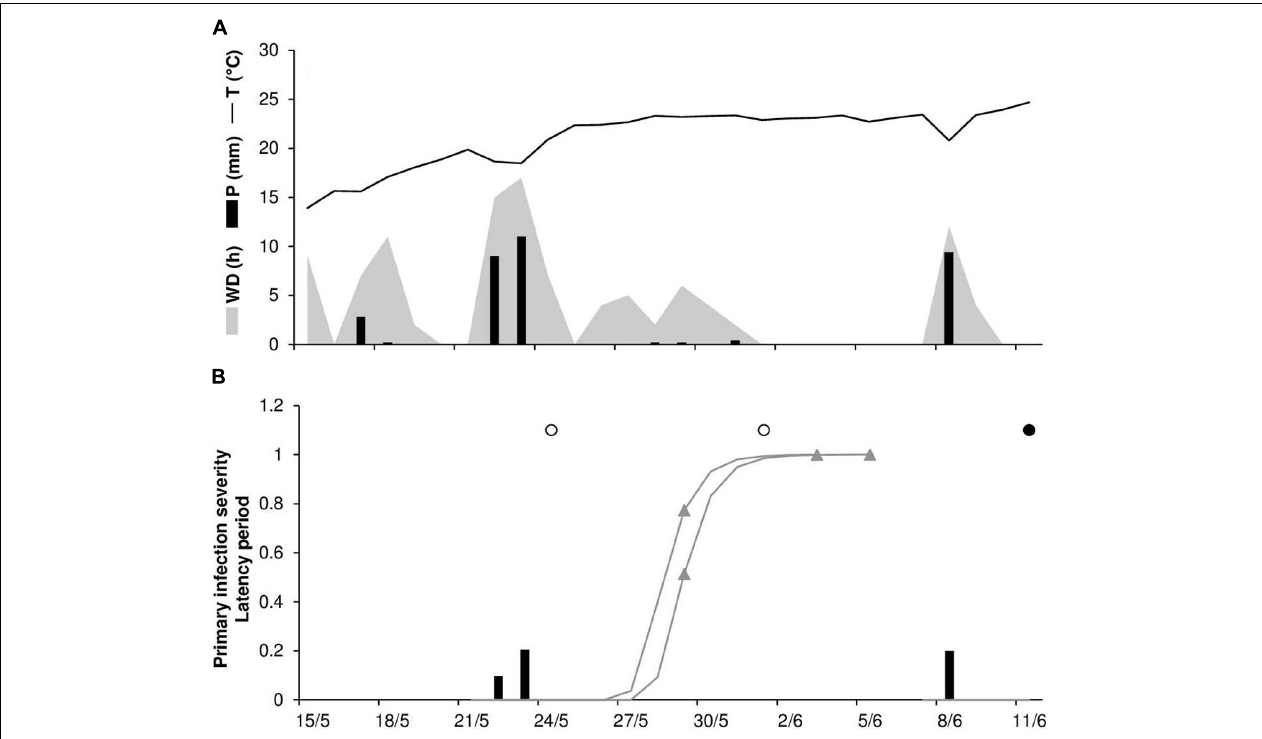
FIGURE 3 | Predicted and observed primary infection onset in the experimental wheat field in Ravenna, Italy, in 2018 (RAV18). (A) Weather variables: air temperature (T, ◦ C, solid line), rainfall (R, mm, black bars), and wetness duration (WD, in h, gray area). (B) Predicted primary infection (black bars); progress of latency (gray line); period of uredia eruption, from 50 to 100% of erupted uredia (line between triangles); days on which stem rust symptoms were not observed (empty dots); days on which uredia were observed in field plots (full